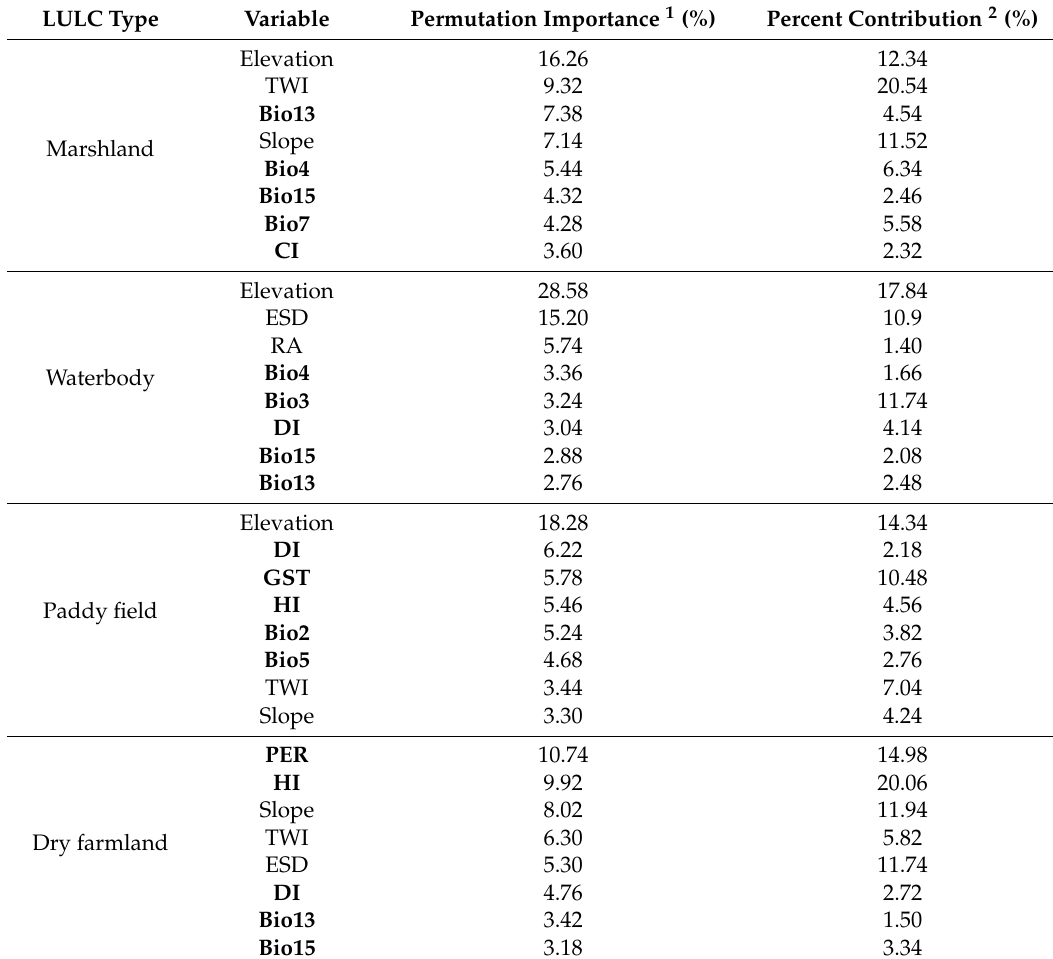
Table 8. Environmental variables (i.e., TOP 3 topographic variables (normal) and TOP 5 climatic variables (bold)) and their averaged percent contribution and percent permutation importance for each of the LULC types in the Maxent model. Variables were arranged in order as permutation importance from the highest to the